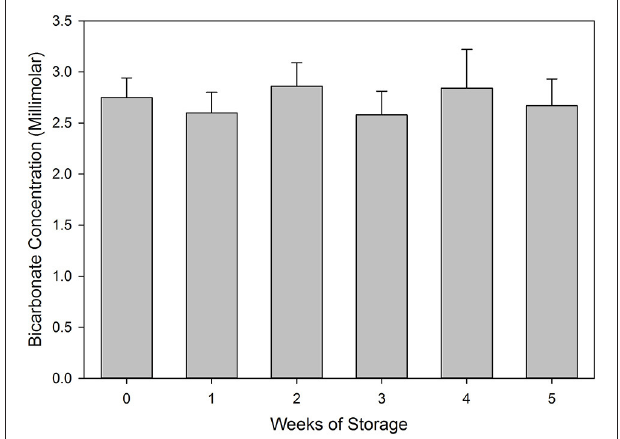
FIGURE 1 | Bicarbonate concentrations measured in samples taken from Meadow Creek at up to 5 weeks in storage. Data represent the mean of six determinations plus standard deviation of the mean.